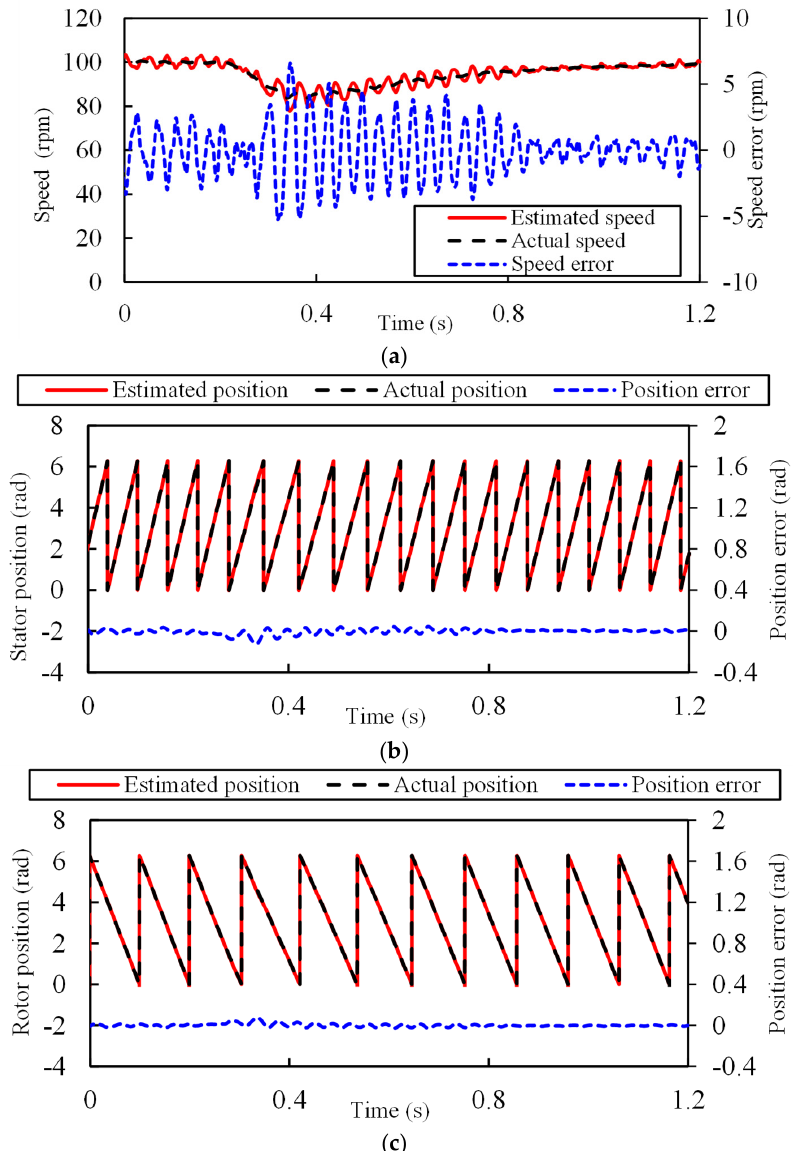
Figure 15. The load step results of estimating from the same side. ( a ) Speed. ( b ) Stator position. ( c ) Rotor position.